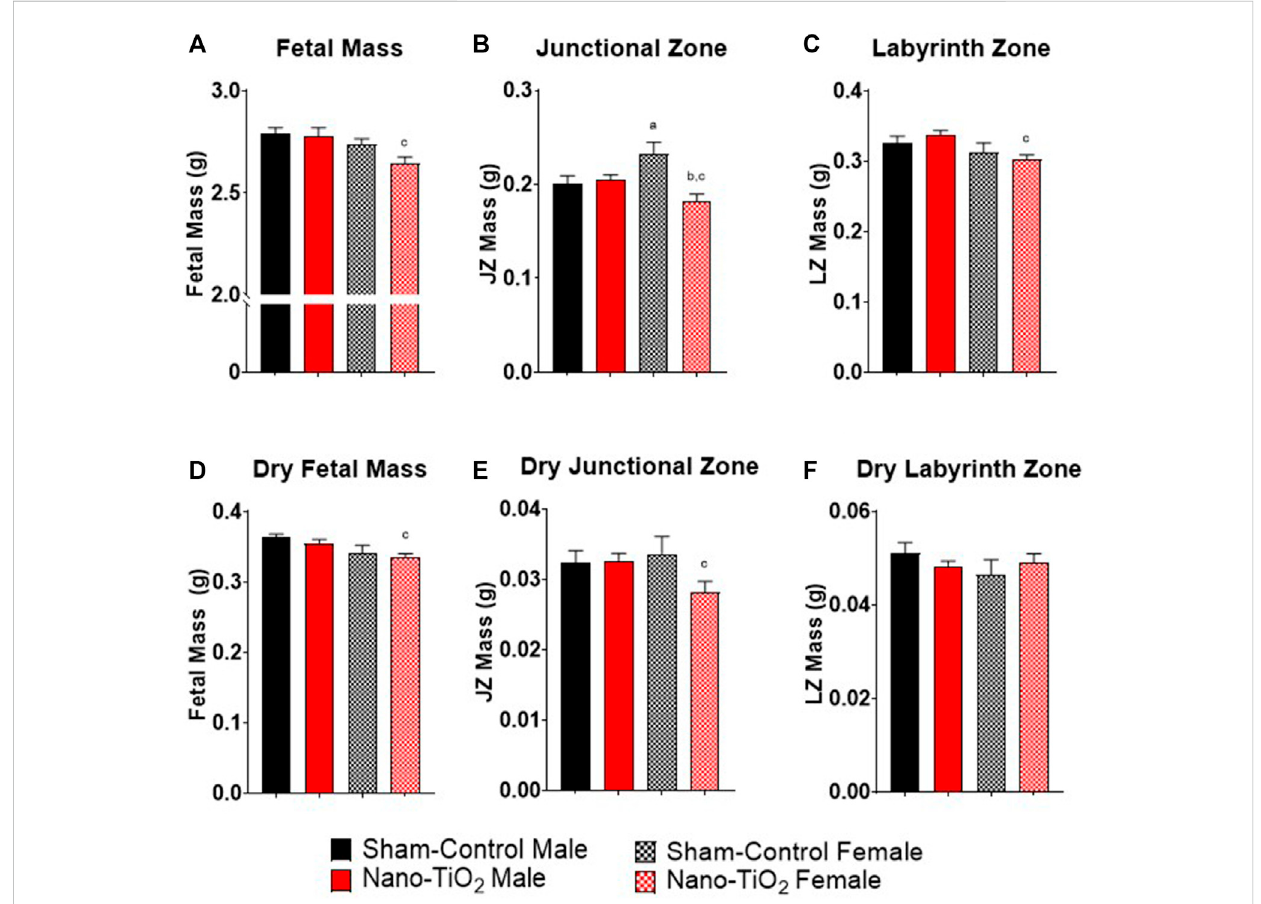
FIGURE 2 Fetal Pup and Placental Zone Mass. Fetal and placental mass were recorded based on fetal sex on GD 20 (N = 13, sham-control fetal male and female,andN=14,nano-TiO 2 fetalmaleandfemale). (A) Wetfetalmass. (B) Wetjunctionalzonemass. (C) Wetlabyrinthzonemass. (D) Dryfetalmass. (E) Dryjunctionalzonemass. (F) Drylabyrinthzonemass.a, p ≤ 0.05vssham-controlfetalmale.b, p ≤ 0.05vssham-controlfetalfemale.c, p ≤ 0.05vsnano- TiO 2 fetal